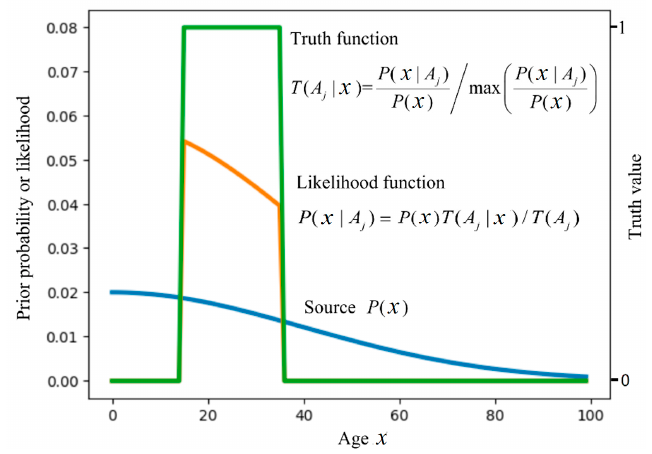
Figure 2. Relationship between T ( A j | x ) and P ( x | A j ) for given P ( x ).